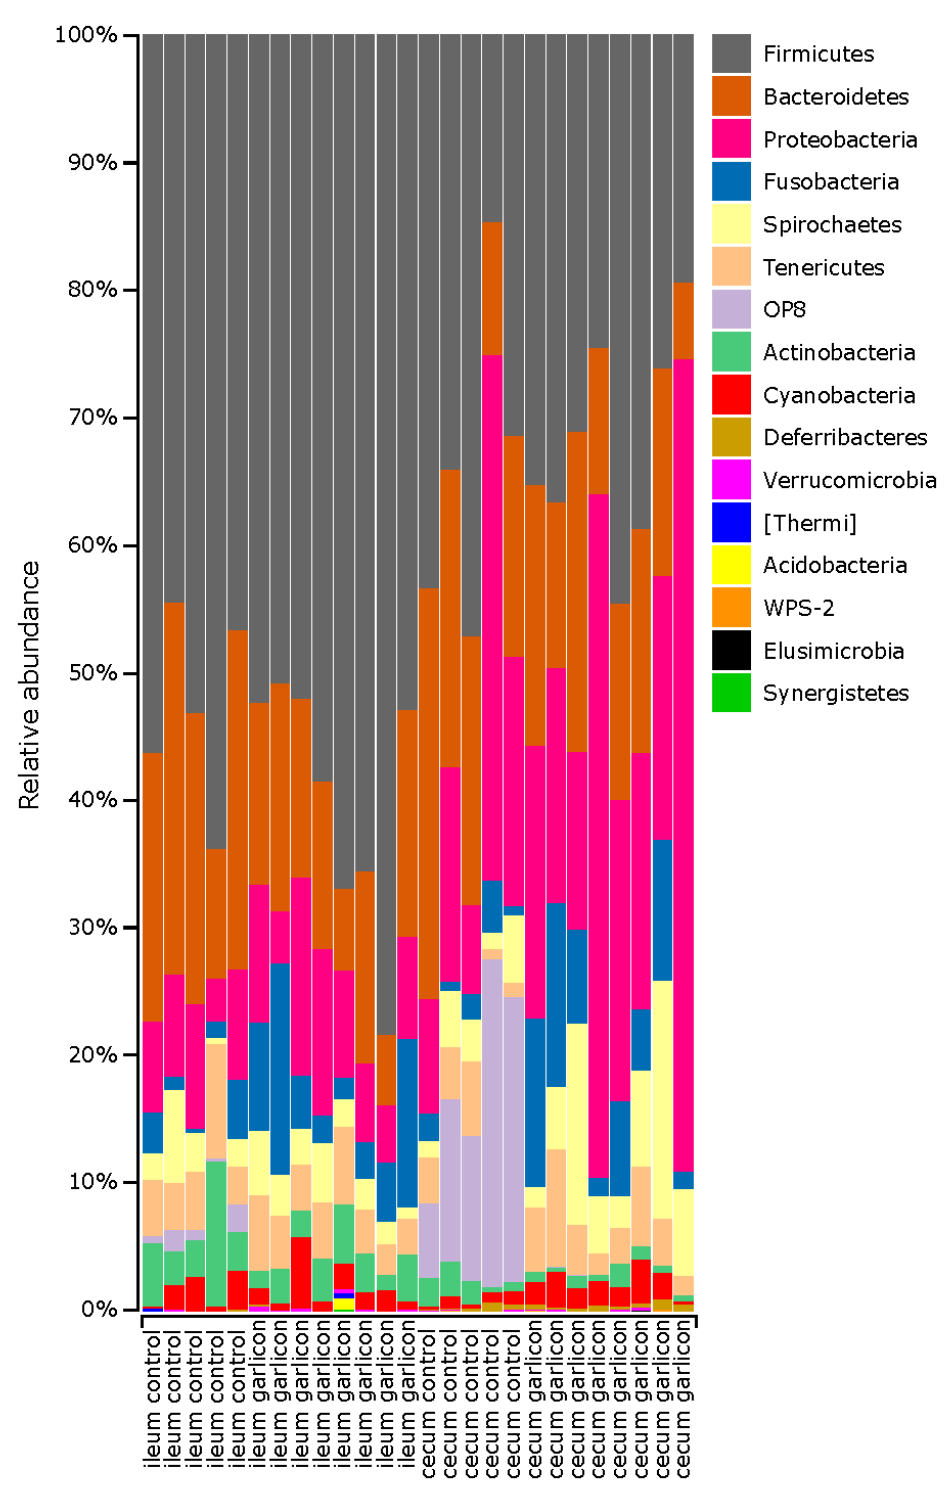
Figure 3. Bar plot of the relative bacterial abundance at the phylum level in different gut regions of laying hens and treatments. Control refers to laying hens fed a basal diet while Garlicon refers to experimental laying hens fed a basal diet supplemented with a commercial Alliaceae extract.